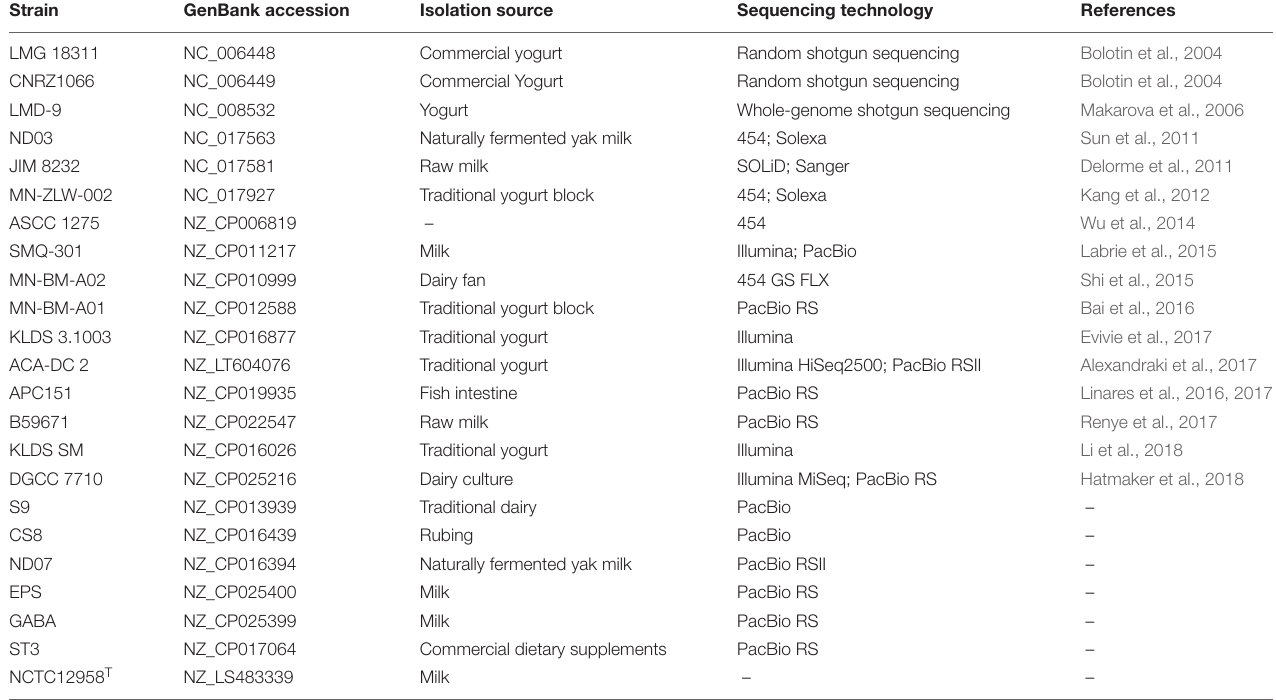
TABLE 1 | Streptococcus thermophilus strains with complete genomes analyzed in this